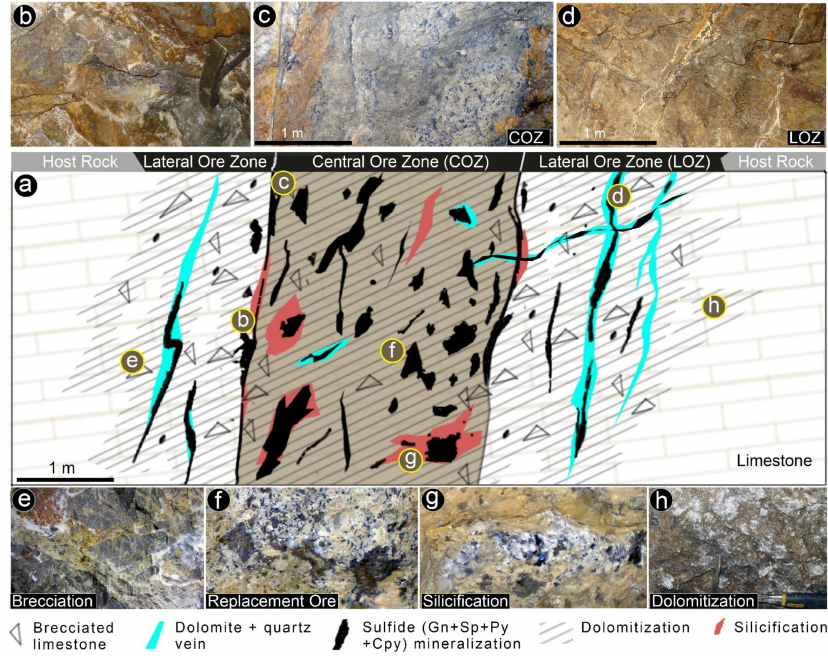
Figure 8. ( a ) A schematic structure of the central ore zone (COZ) and lateral ore zone (LOZ) in sulfide ore veins of the Ab-Bid deposit, showing different hydrothermal alterations and main ore textures. ( b ) Replacement of sulfides in wall-rock; ( c ) The central ore zone; ( d ) Sulfide-bearing veins and veinlets in the lateral ore zone (LOZ); ( e ) Brecciated limestone with hydrothermal dolomitization; ( f ) Replacement sulfide ore in the COZ; ( g ) Silicified patches with sulfide mineralization in the COZ, ( h ) Intense hydrothermal dolomitization in the LOZ.